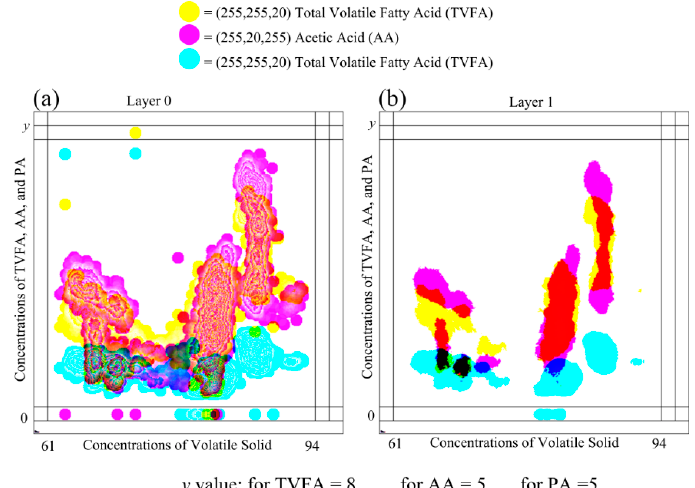
Figure 7. The MLMV ‐ GKU of two layers. ( a ) Layer 0 of the MLMV ‐ GKU; ( b ) Layer 1 of the MLMV ‐ GKU. The effective bitmap width and height are 400 and 400 pixels for representing the data of three dependent variables (concentrations of total volatile fatty acids (TVFA), acetic acid (AA) and propionic acid (PA)) against the concentration of volatile solids where each dependent variable consists of 2885 data points. All of the data are normalized using the max ‐ min normalization method using 400 pixels as new_max A for all dependent variables (absolute scaling). The initial color of each variable is (255, 255, 20), (255, 20, 255) and (20, 255, 255). A circle of a radius of 10 pixels is used as the data point shape (DPS). The MLMV-GKU shows the density clusters of each variable by means of automatically-generated contour lines, which can be easily identified by the naked